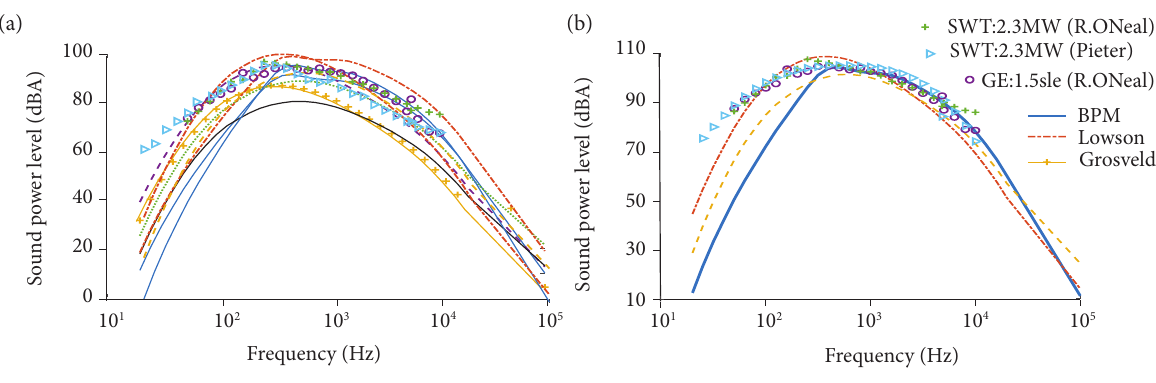
(R.ONeal) SWT:2.3MW (Pieter)